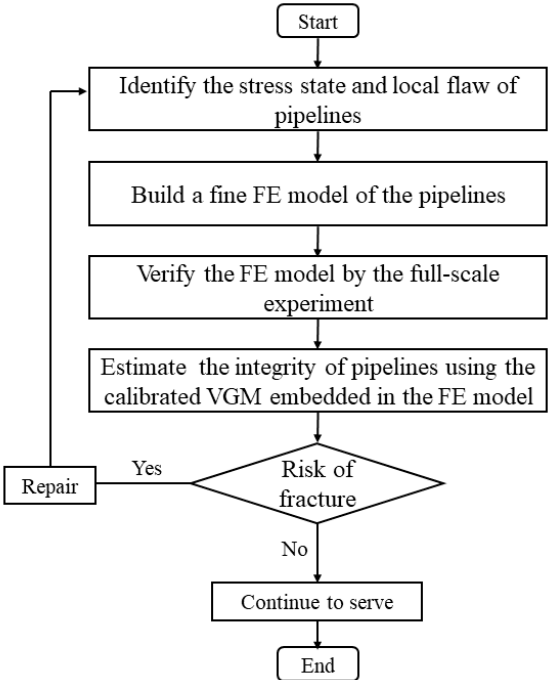
Figure 17. Flowchart of application of the calibrated VGM for the real pipelines.